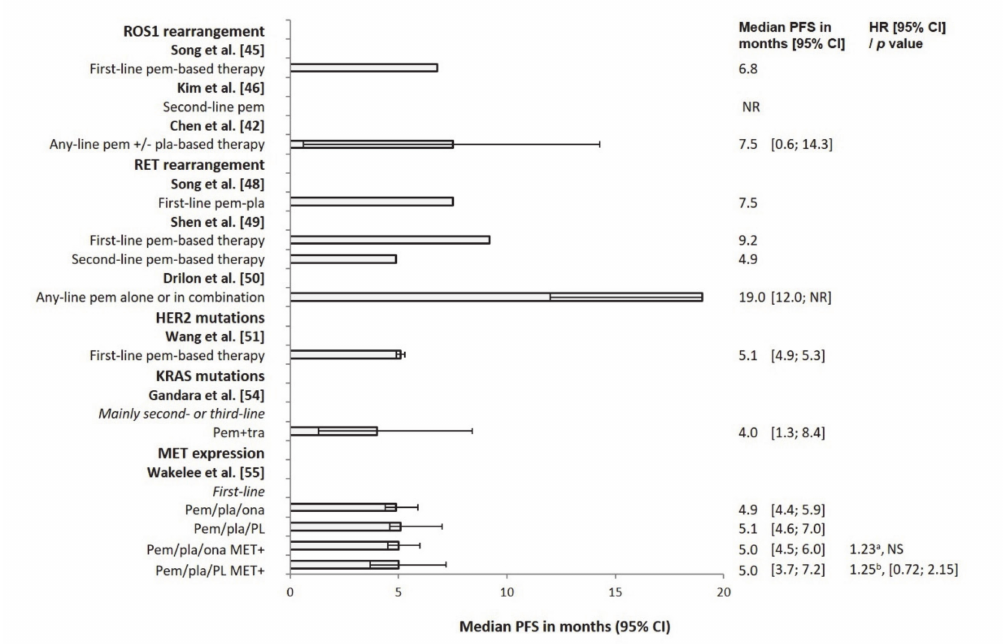
Figure 3. Median PFS with pemetrexed-based treatment in patients with advanced nonsquamous NSCLC and ROS1 or RET rearrangements, or HER2 or KRAS mutations, or MET expression. a Stratified HR. b Unstratified HR. Abbreviations: confidence interval (CI); human epidermal